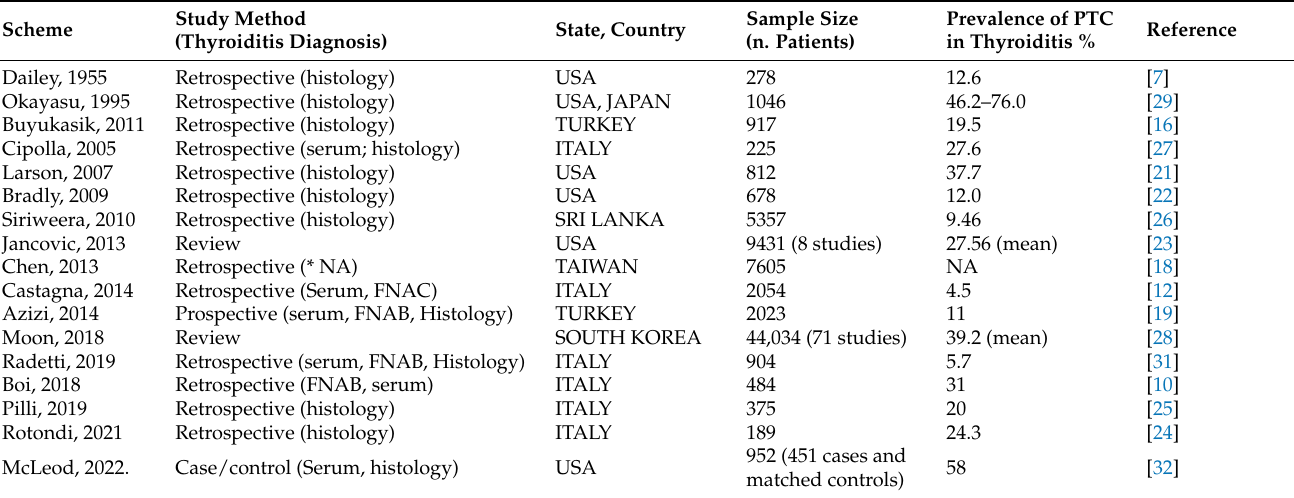
Table 1. Summary of surgical, cytological, and pathological human